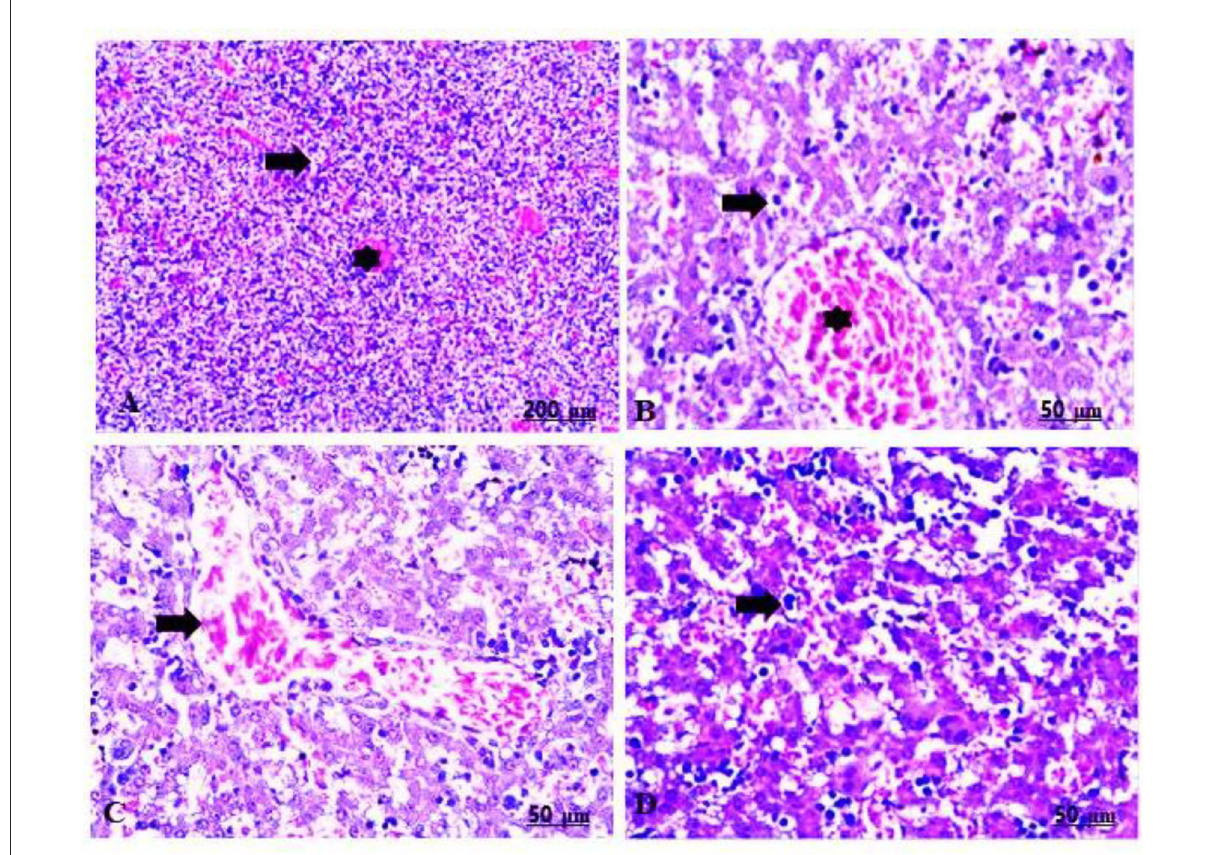
FIGURE4 (A–D) Light photomicrograph of sections from the fetal liver of CHTiO 2 NPs exposed groups. CHTiO 2 NPs of 100 mg/kg bwt showing extensive hepatic vacuolation (arrow), thrombotic vasculitis of the central vein, and lymphocyte infiltration (star) (A,B) . CHTiO 2 NPs of 300 mg/kg bwt